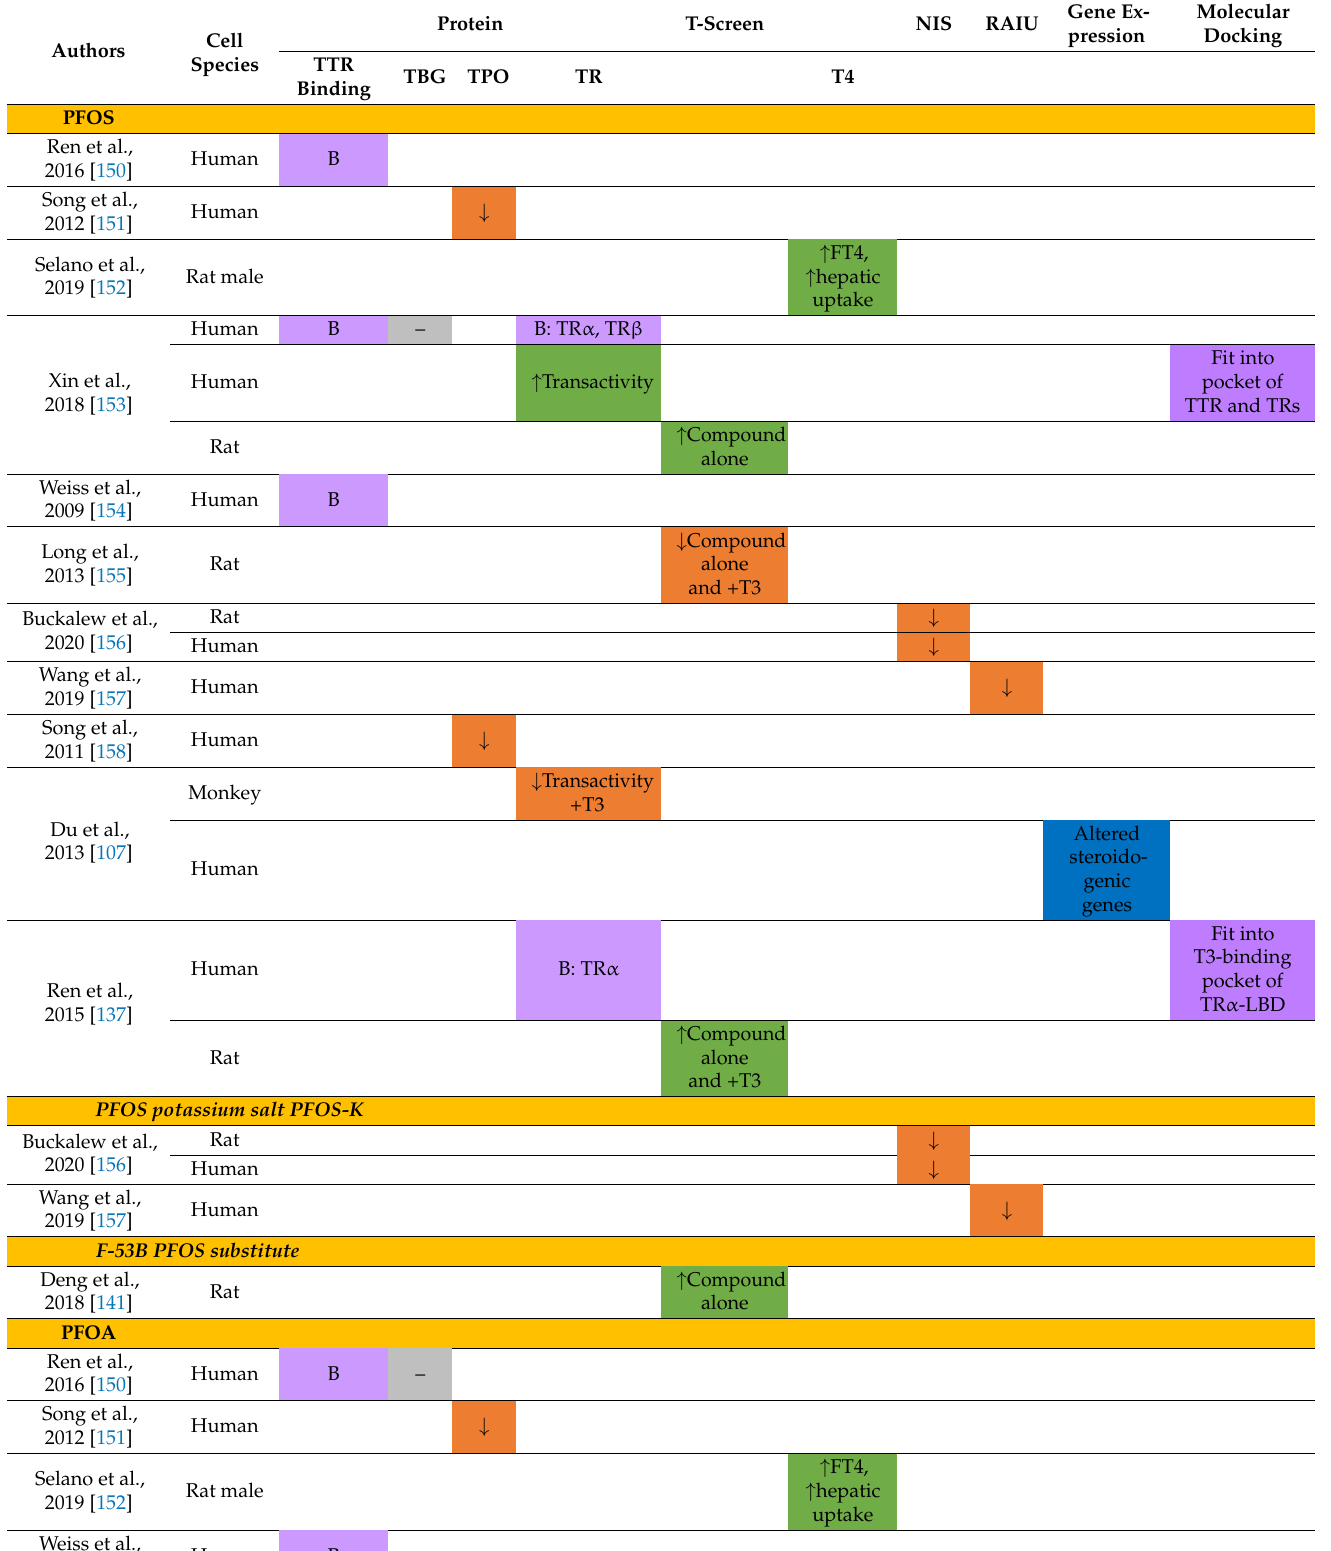
Table 11. In vitro results related to PFAS exposures and thyroid hormone